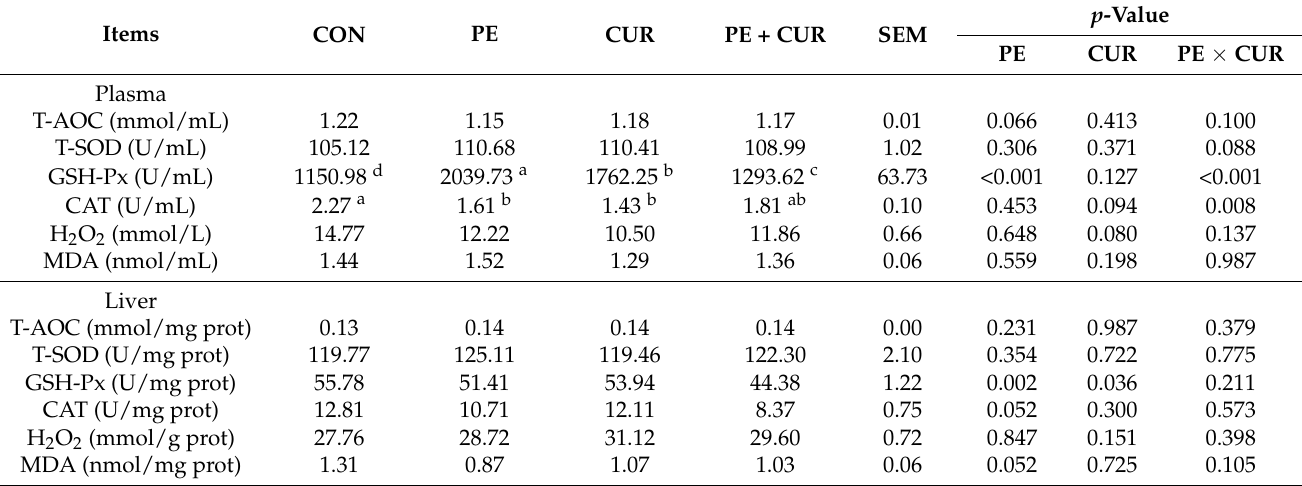
Table 4. Effects of dietary supplementation with PE and CUR on antioxidant status in plasma and liver of broilers 1 .